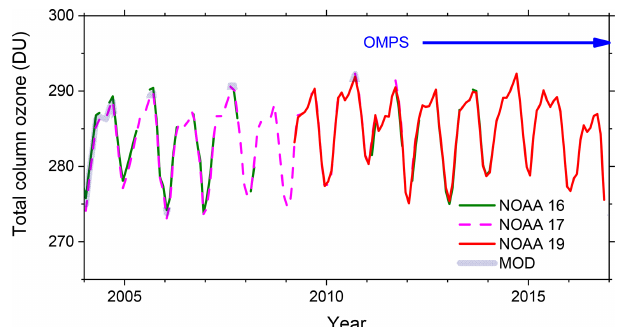
Figure 2. OMPS ozone will be compared with MOD (merged ozone data) ozone created by merging data from recent SBUV/2 instru- ments. Monthly average ozone for 60 ◦ S–60 ◦ N is